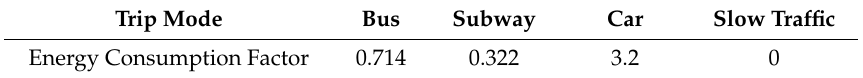
Table 2. Transportation default energy consumption factor for different trip modes (MJ/p.km).